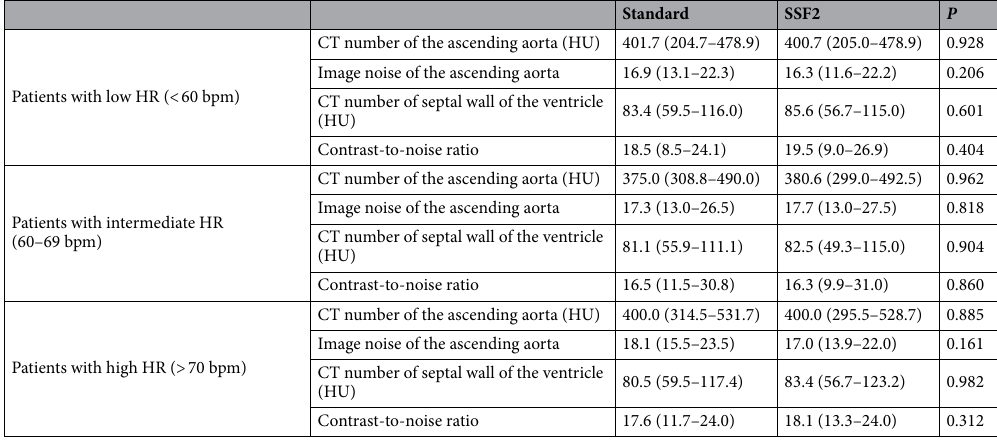
Standard SSF2 P